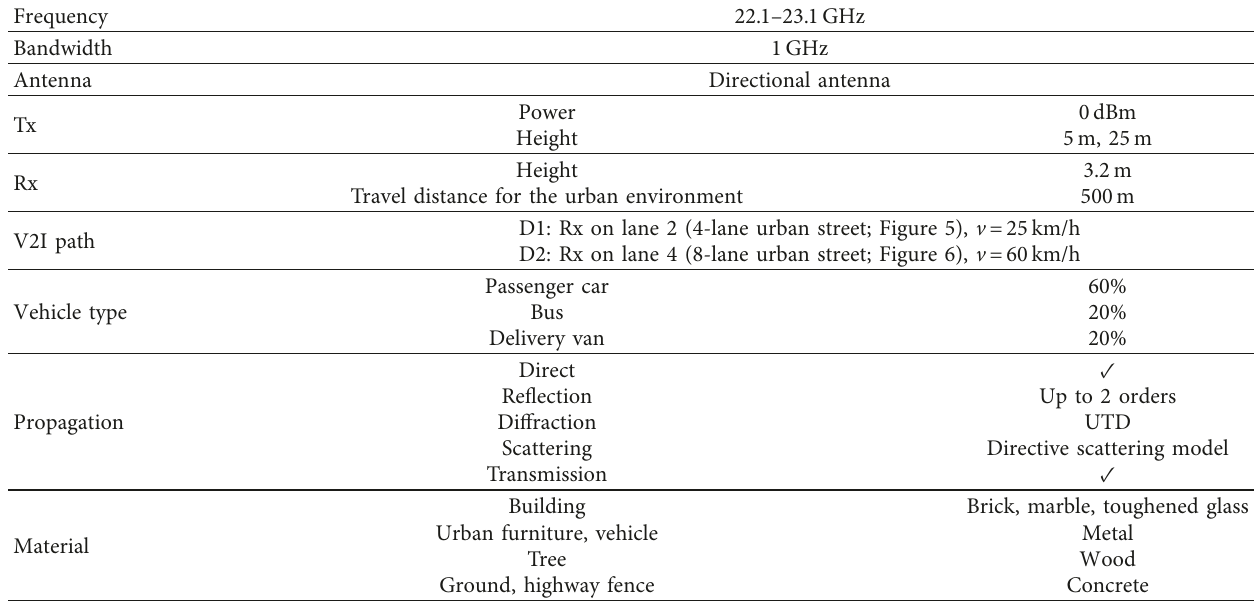
Table 3: Environment